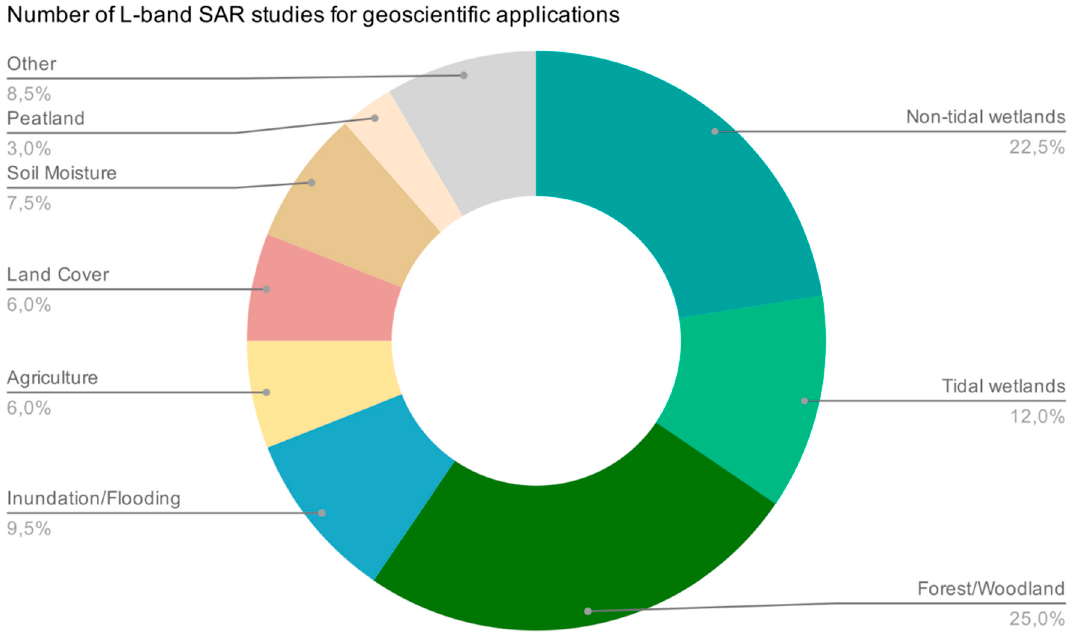
Figure 10. Number of reviewed research articles per research focus.